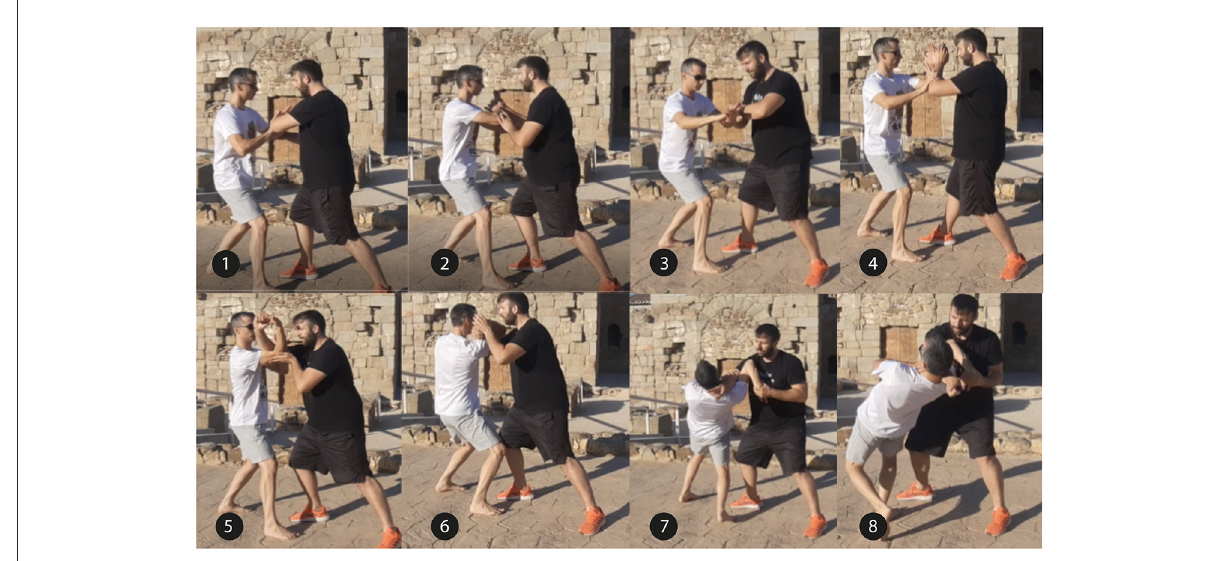
FIGURE3 Tuishou: Nacho de la Encina on the right (Official Representative in Europe of The Line of Zhang Zhijun Chen Shi Taiji) working in pair with Miguel Barberá on the left (Black Belt 1 ◦ Dan).